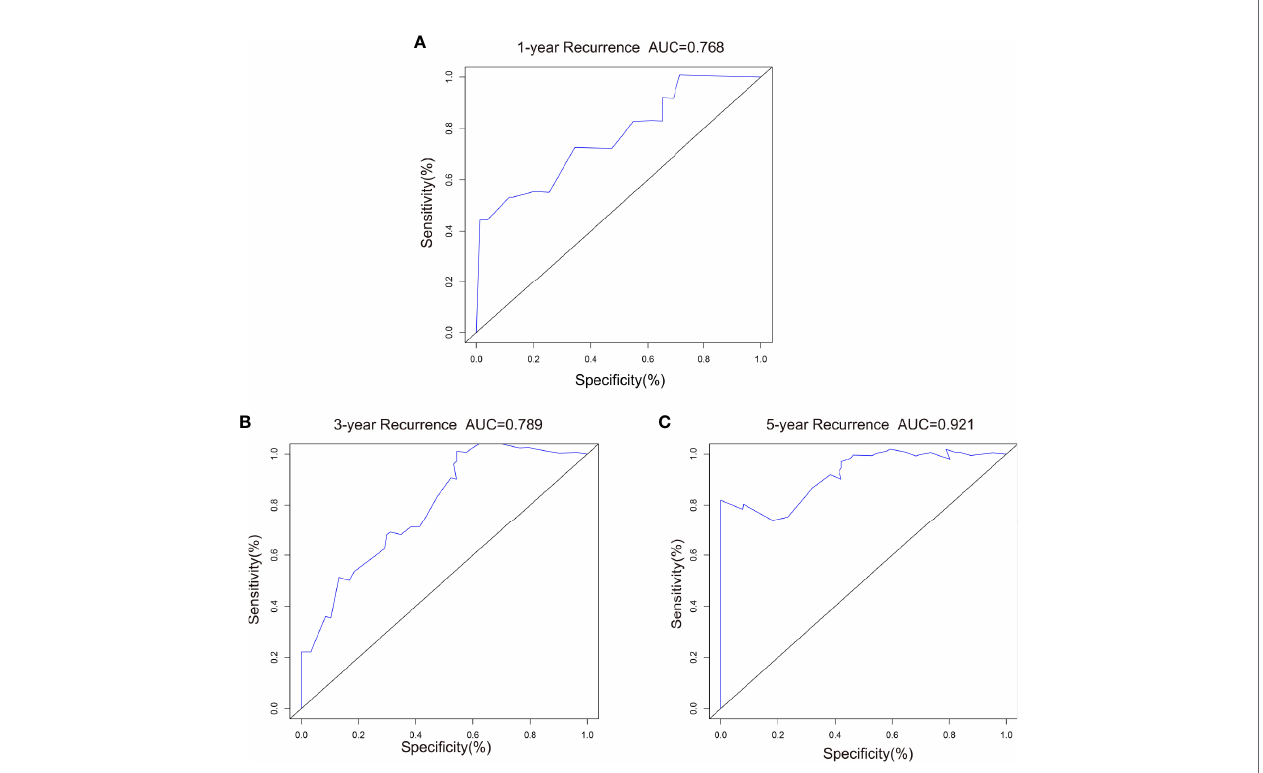
FIGURE 7 | ROC curves comparing the effectiveness of predicting (A) 1-, (B) 3-, and (C) 5-year IV-RFS between the nomogram and the AJCC score in the validation cohort. Nomogram-predicted intravesical recurrence-free survival rates are indicated by the blue